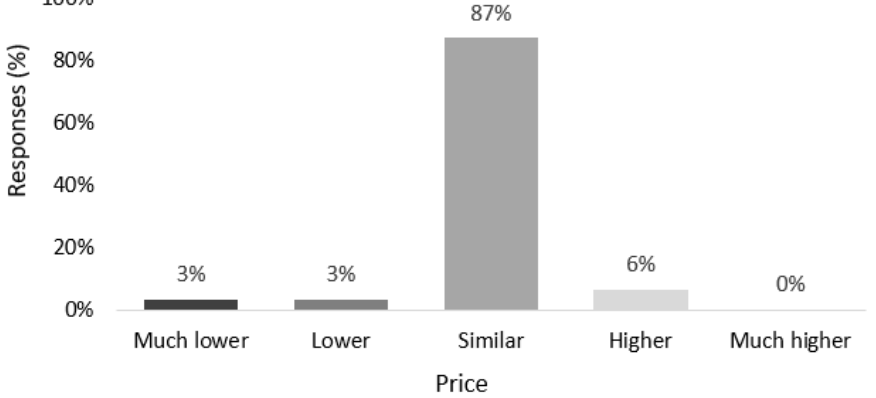
Figure 7. Sale price of PEFC Fair supply chain labeled products compared to similar, non-labeled products sold by respondents.